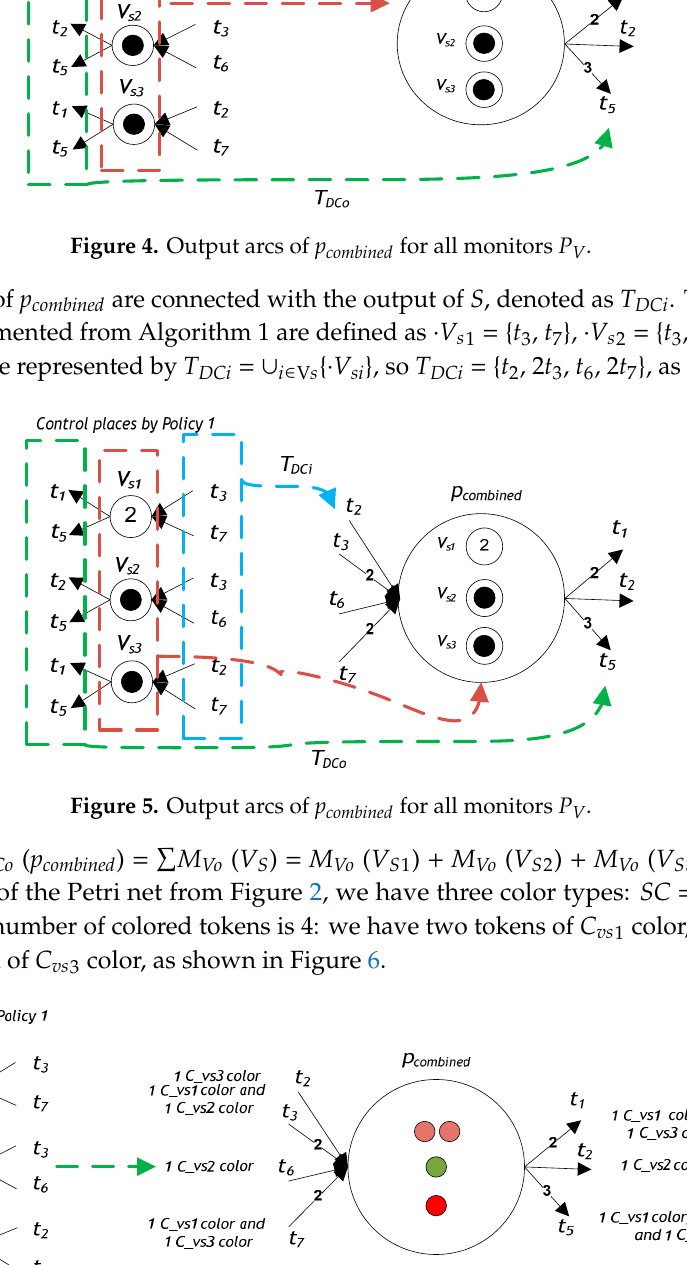
Figure 3. Merged control place for all monitors P V .